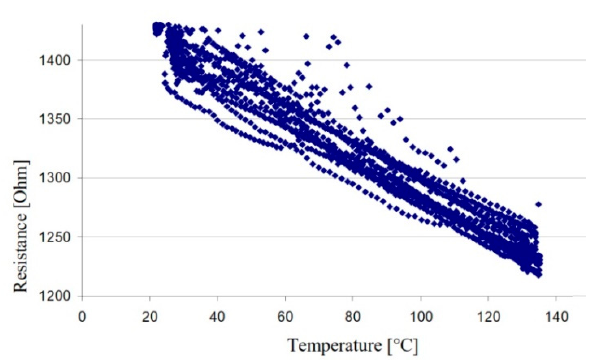
Figure 4. ( a ) SEM images of the CNT based temperature sensor investigated by de Volder . Reproduced from [29], courtesy of Michael De Volder; ( b ) forces applying on CNTs during Co. KGaA, Weinheim.